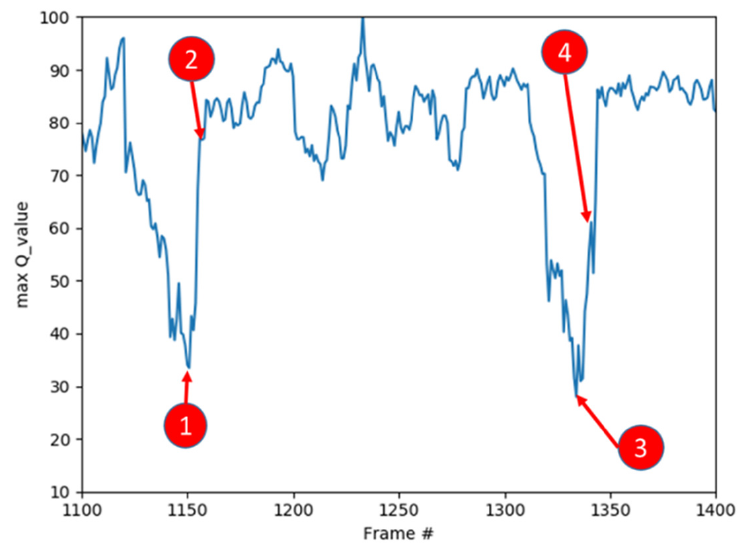
Figure 21. Trend graph of maximum Q value. Each meaning of numbers 1–4 is explained in Figure 22.